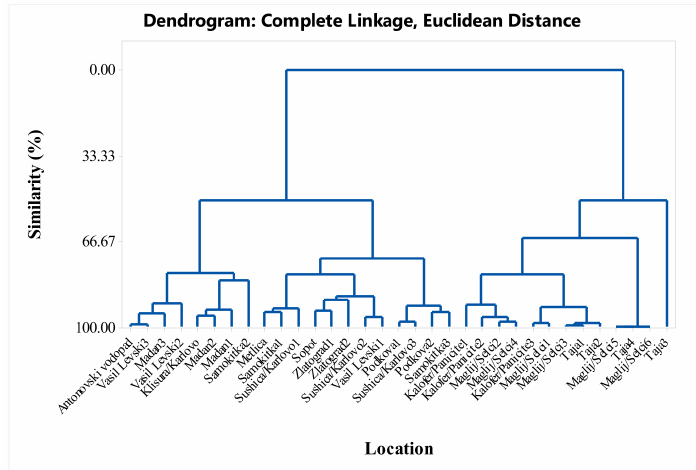
Figure 5. Complete linkage dendrogram showing the similarity of 33 locations in terms of thymol and p -cymene of Satureja pilosa .